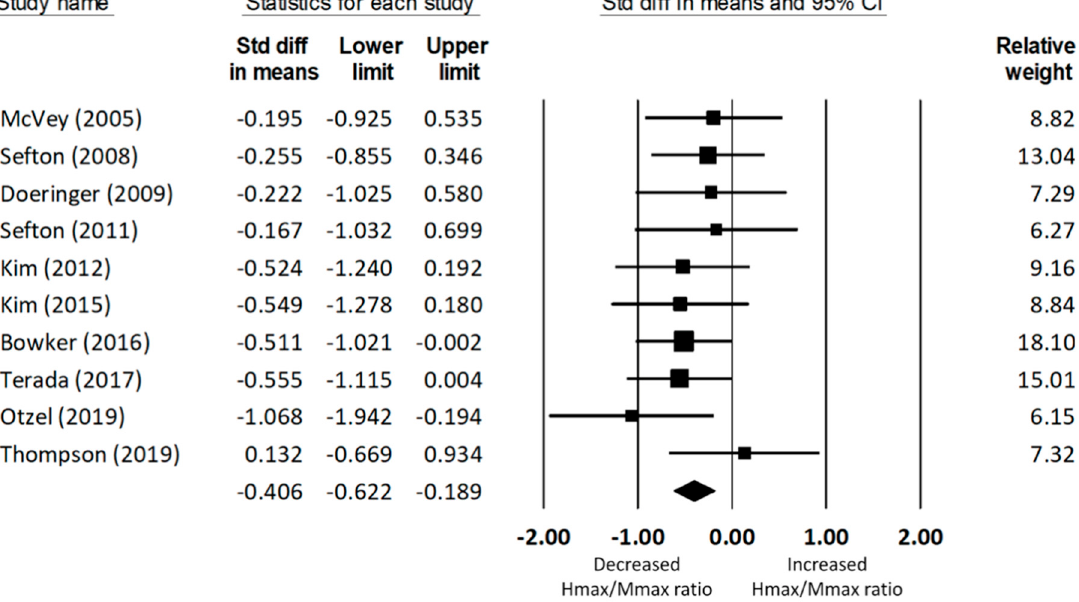
Figure 3. Forest plot illustrating Cohen’s d effect sizes for the fibular longus Hmax/Mmax ratio between groups with and without CAI and their 95% confidence intervals. Figure 4. Forest plot illustrating Cohen’s d effect sizes for the soleus cortical motor threshold between groups with and without CAI and their 95% confidence intervals.